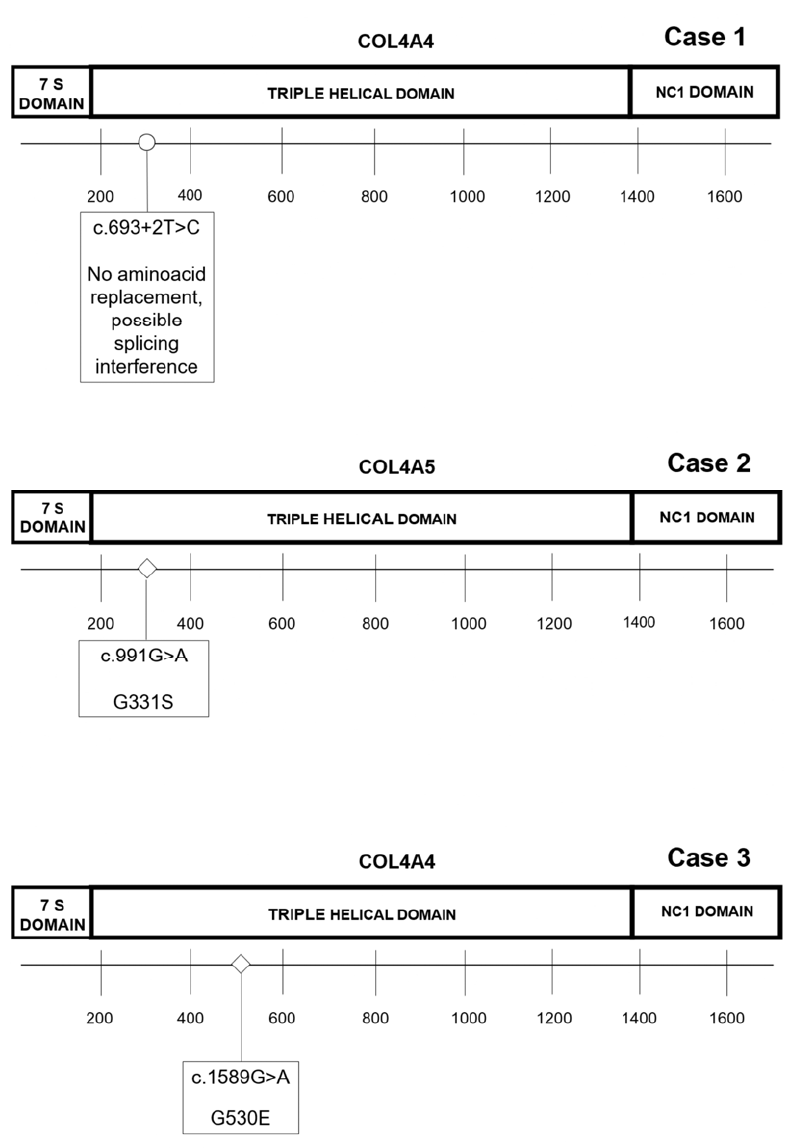
Figure 6. DNA variants of COL4 patients and resulting protein change.